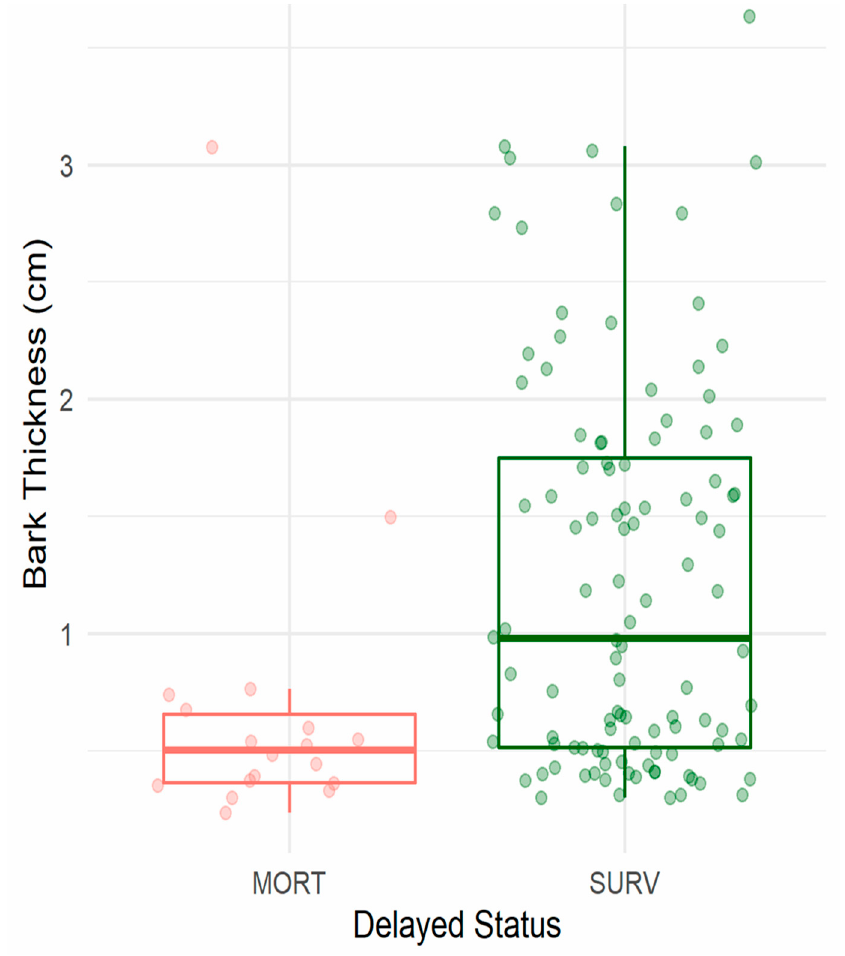
Figure A1. Boxplot of bark thickness for incense-cedar (CADE) by mortality(mort) and survivor trees.